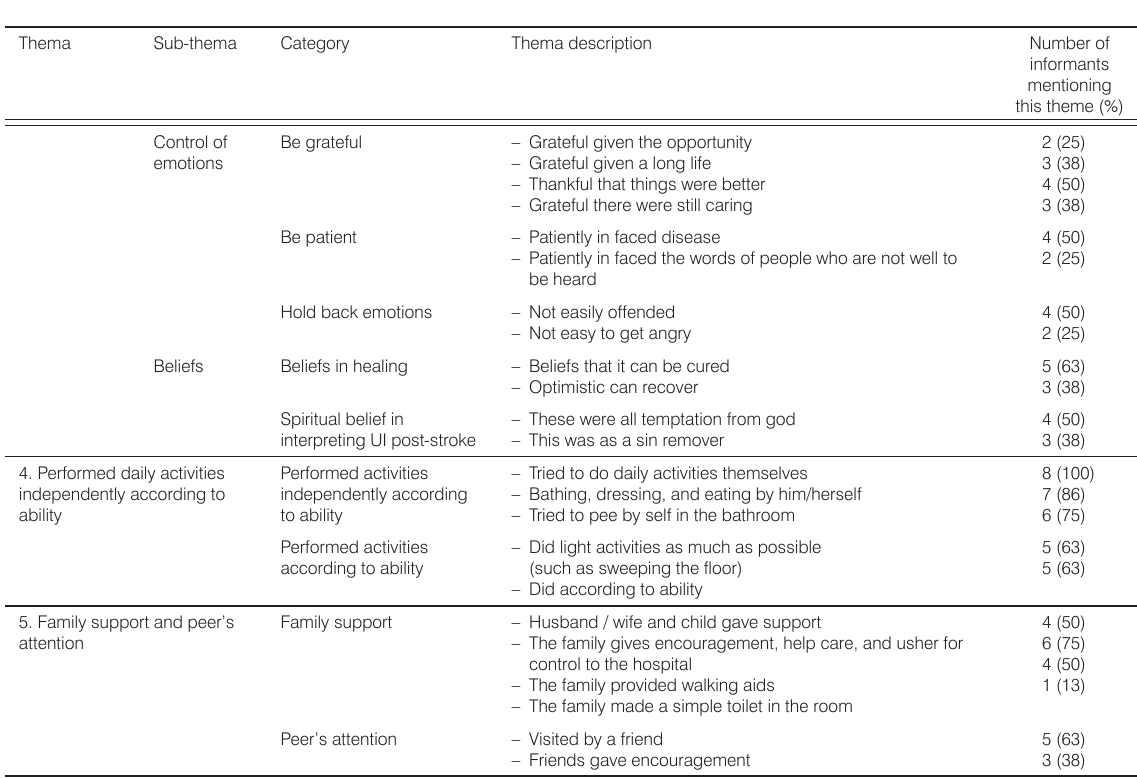
Table 2. Thematic